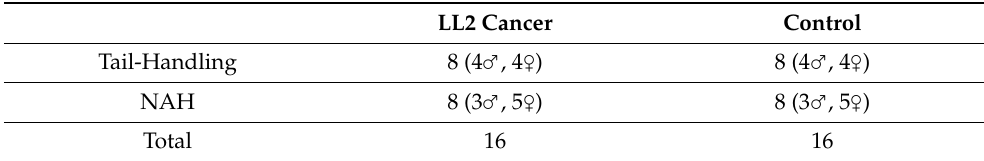
Table 1. Final numbers of mice assigned to each treatment group in mice exposed to standard tail-handling or non-aversive handling